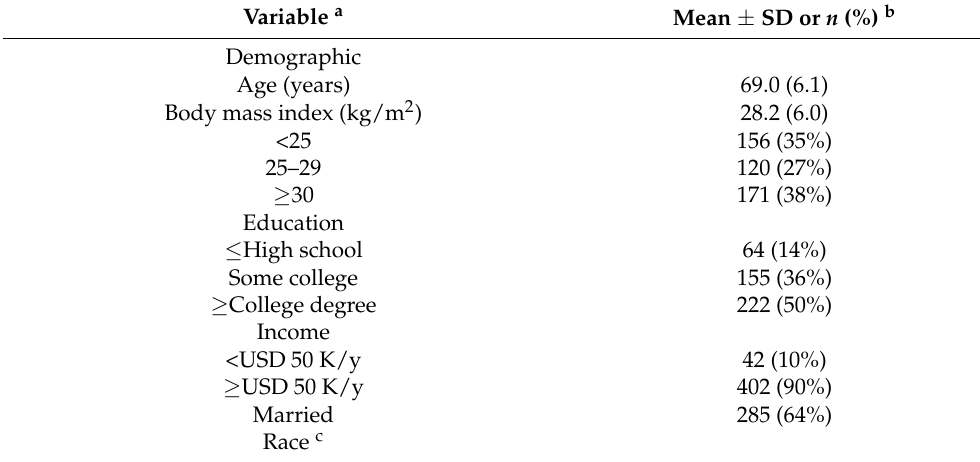
Table 1. Covariates evaluated for the 444 women in the WHI NPAAS-OS observational